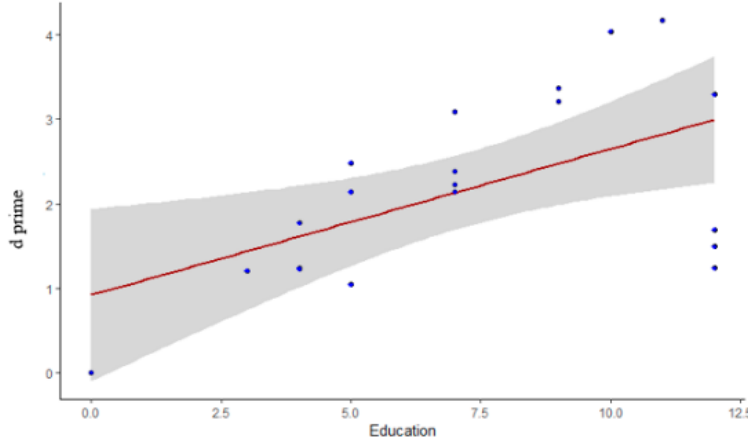
Table 1. The sound inventory of Omani Arabic (The highlighted consonants are absent from the L1 inventories of the FDH).